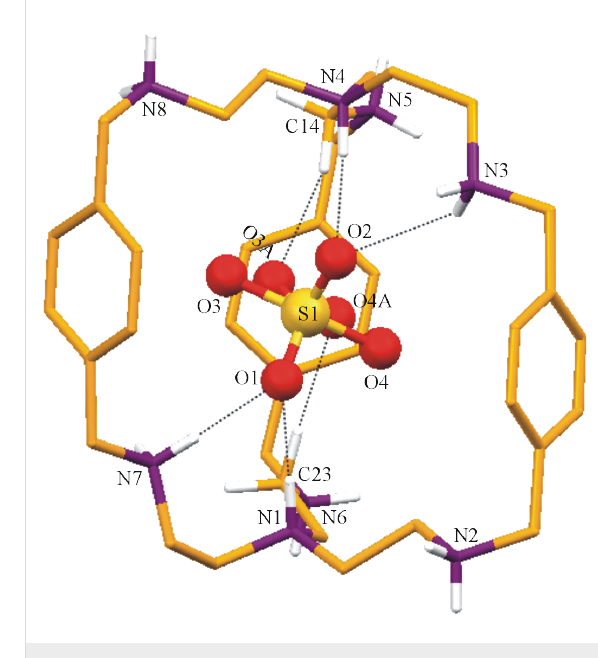
Figure 5: Mercury diagram depicting the encapsulation of disordered hydrogen sulfate in the cavity of [H 8 L 1 ] 8+ through various hydrogen bonding interactions.